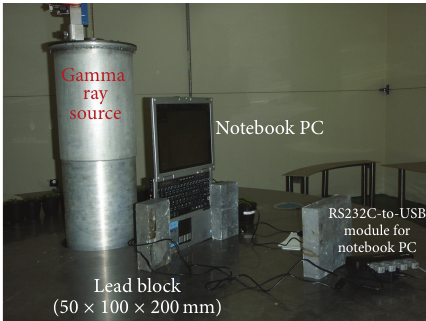
Figure 5: Menu image of the pilot application program, executed on a notebook PC under test (during gamma ray irradiation, about 15 min